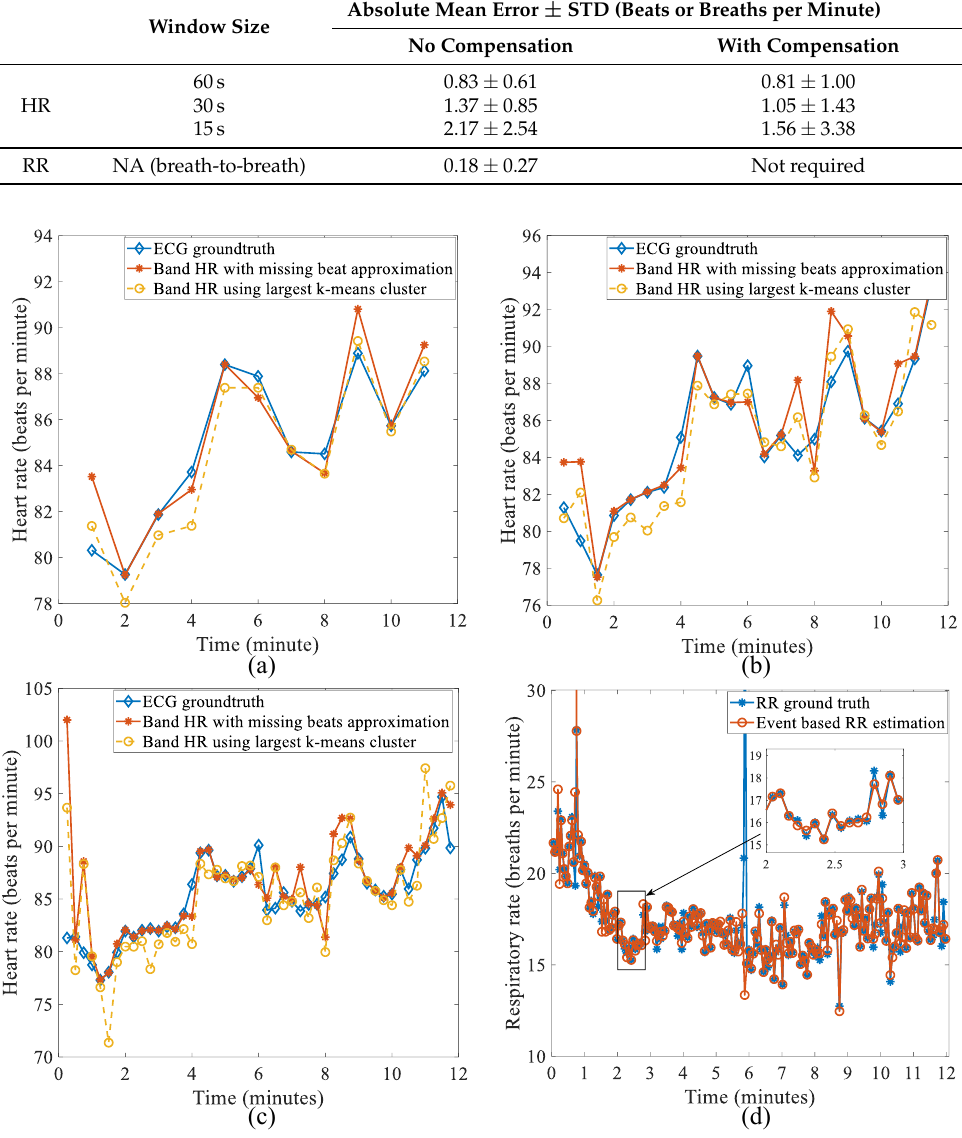
Figure 10. HR and RR estimation compared with ground-truth for the k-means algorithm. ( a ) HR estimation using a 1 min window. ( b ) HR estimation using a 30 s window. ( c ) HR estimation using